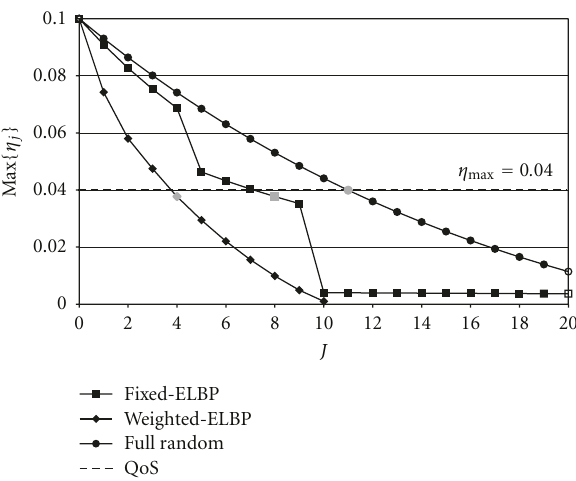
Figure 10: Maximal PLR versus the number of ACK-leaders.